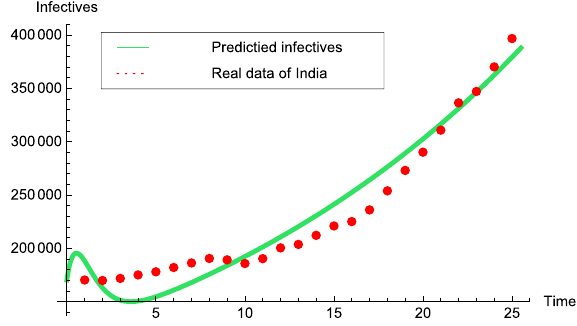
Figure 3. Graph illustrating the validation of model system to the real data of India for the time interval March/01-March/25/2021: Red dots and Green solid line depict the real data and predicted trajectory, respectively, for the model system